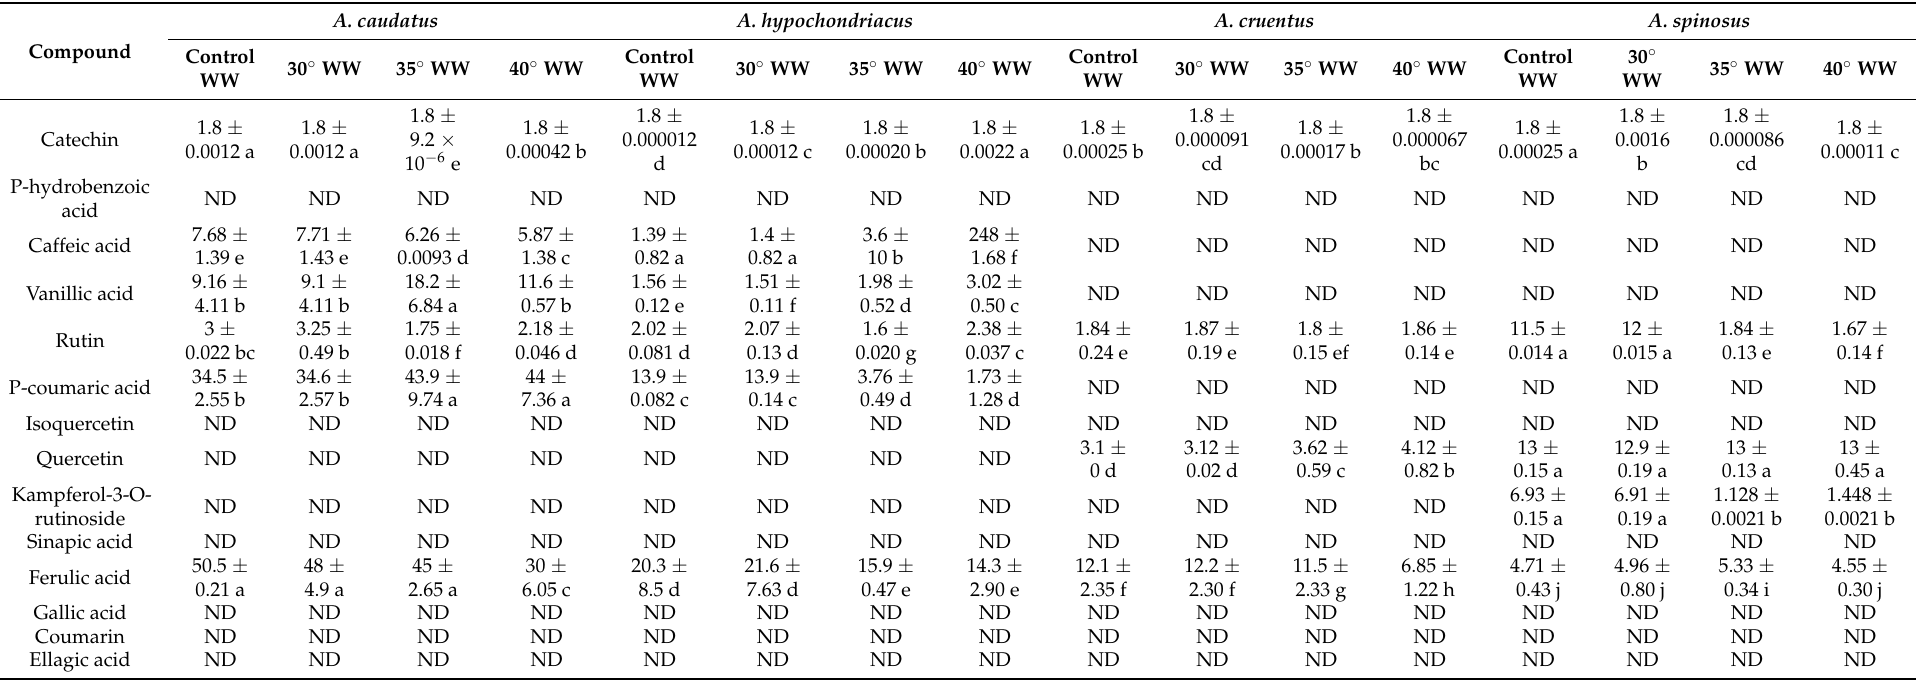
Table 4. Individual phenolic and flavonoids compounds contents detected in aqueous leaves extracts of Amaranthus species treated with different temperature regimes under WW condition ( µ g/g DW). ND (not detected). Data are shown as mean ± standard deviation and different letters in the same row indicate significant differences ( p ≤